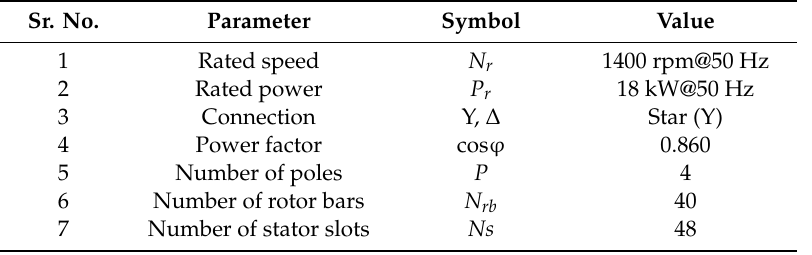
Table 1. Motor specifications.